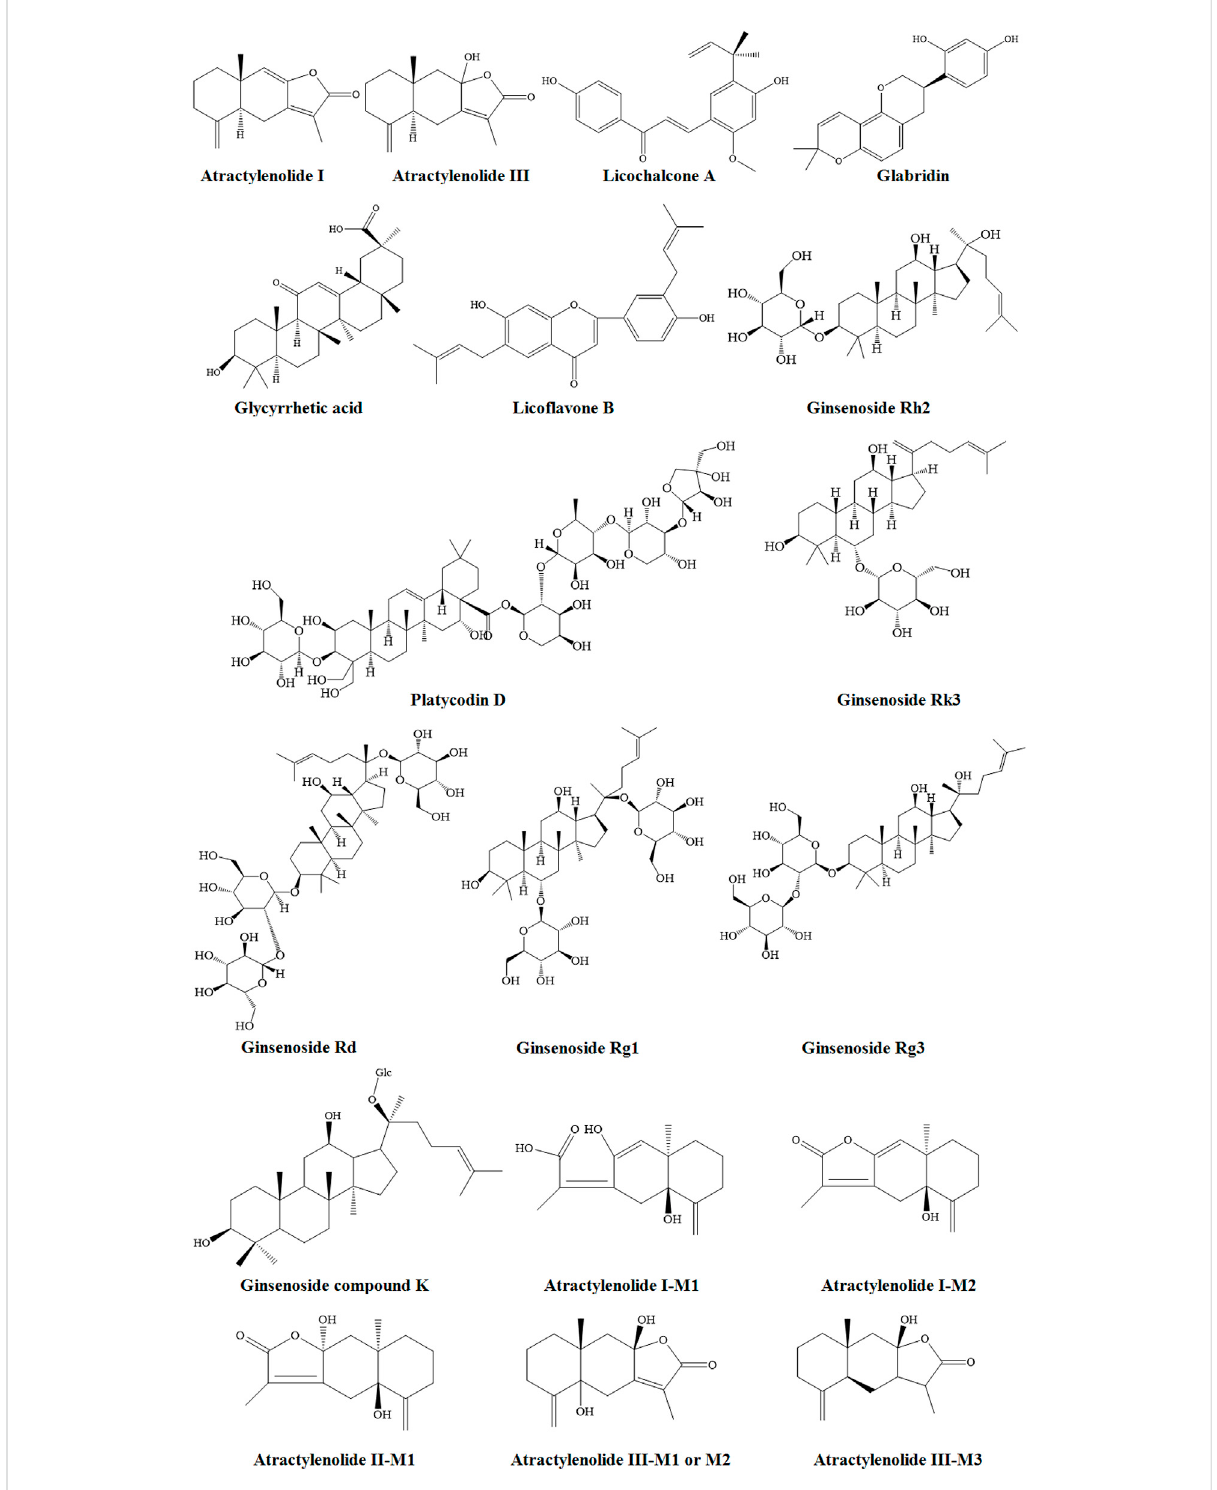
FIGURE 7 The structures of prototype and metabolites components of herbs in